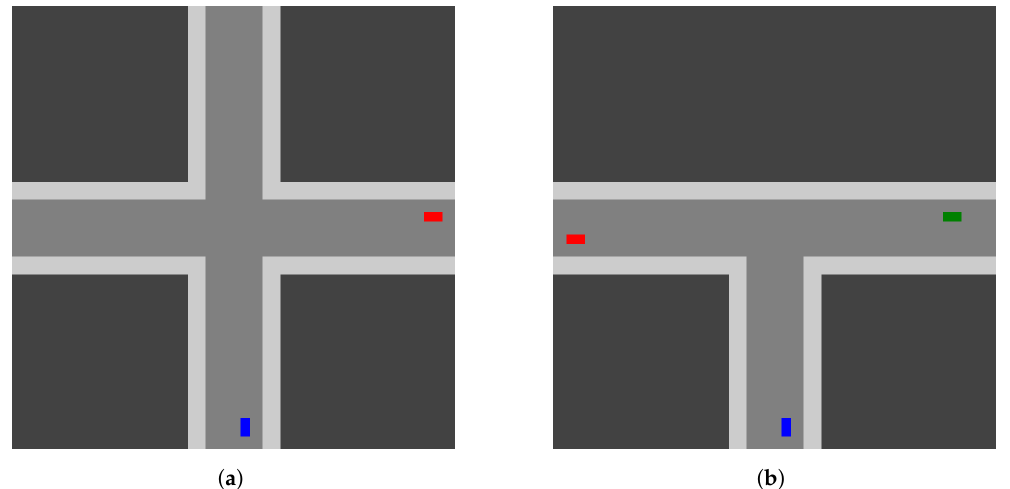
Figure 7. Key interaction zones for driving scenario(s), with cars represented by blue, red, and green rectangles. ( a ) Four-way intersection and ( b )